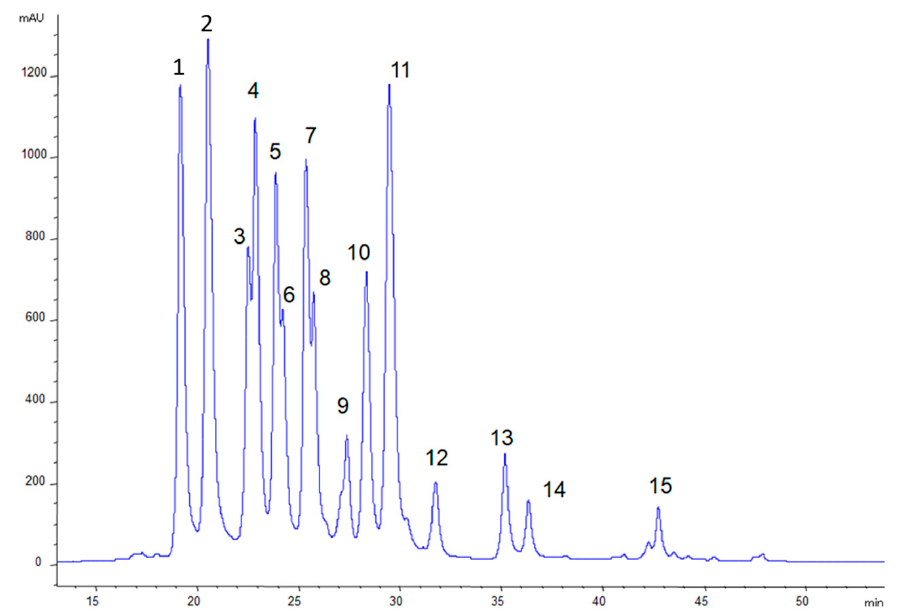
Figure 1. HPLC chromatogram recorded at 520 nm of the bilberry purified anthocyanin extract. For peak identification, see Table 1. Table 1. Content of anthocyanins in the lyophilised bilberry extract expressed as mg / g (delphinidin 3- O -glucoside equivalents) of dry